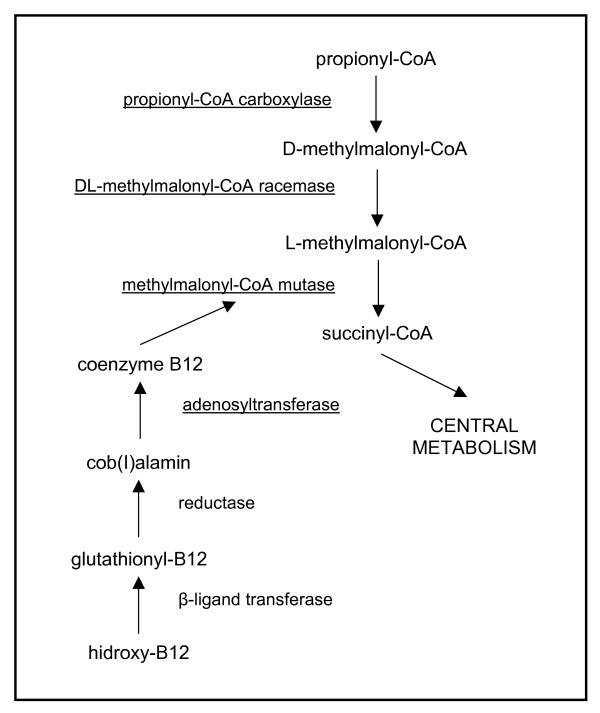
Scheme of the pathway of cobalamin-dependent propionyl-CoA metabolism. Enzymes mentioned in the text and in Table 1 are underlined.